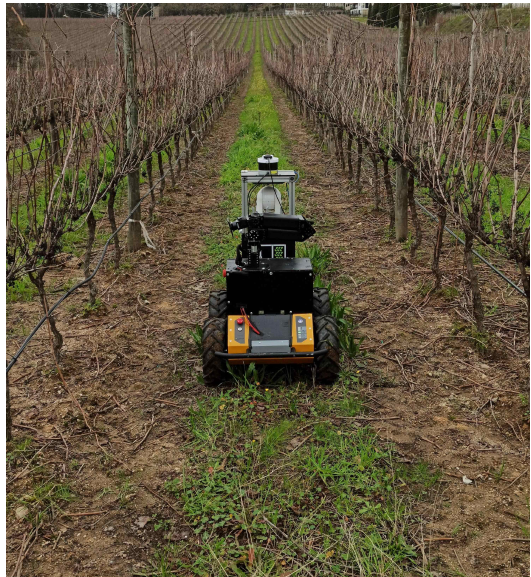
Figure 4. The AgRob V16 robotic platform recording data in one of the vineyards that compose the